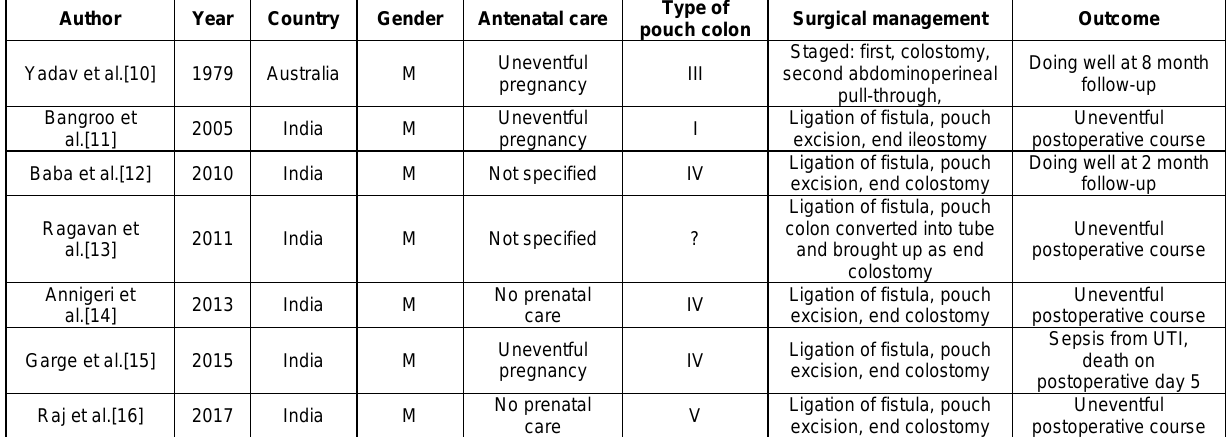
Table 1: Literature review of patients with Prune belly syndrome and congenital pouch